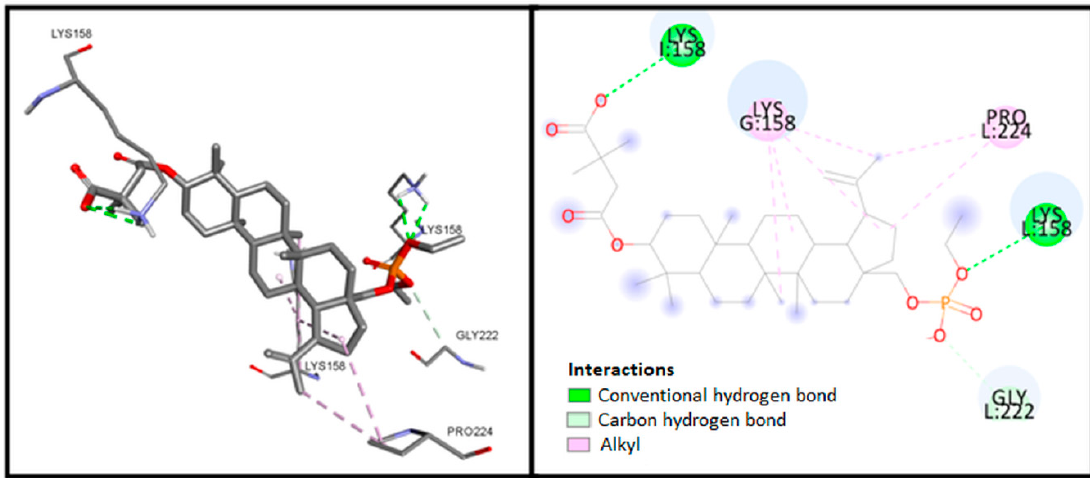
Figure 3. Visualization of interaction between compound 3 and CA-CTD-SP1.